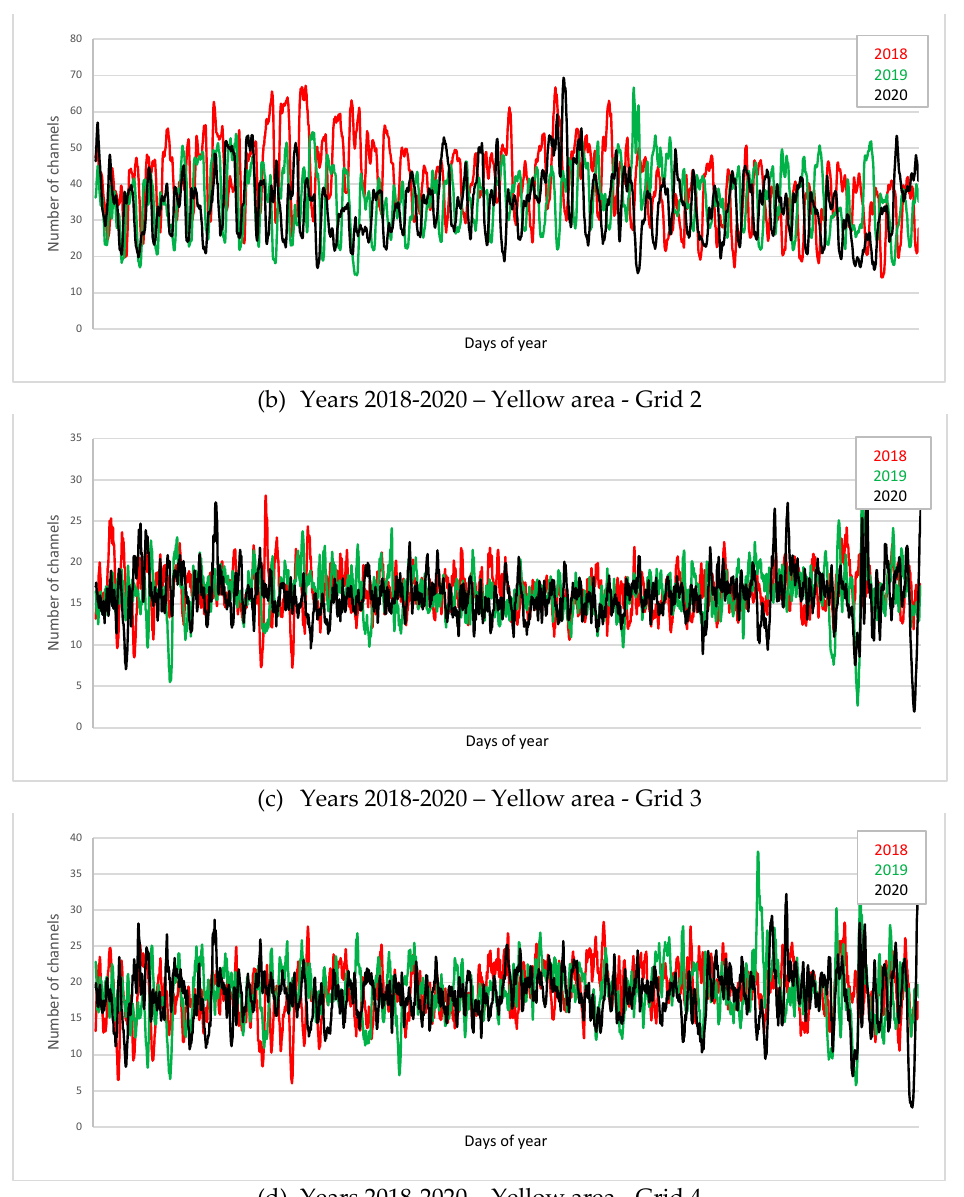
Figure 14. Results corresponding to the number of channels constituted from 2018 to 2020 in the yellow geographical area under study.